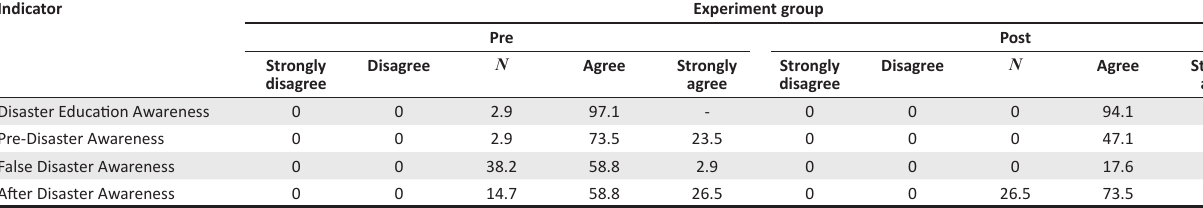
TABLE 6: Percentage of rural students’ responses from experimental groups. Indicator